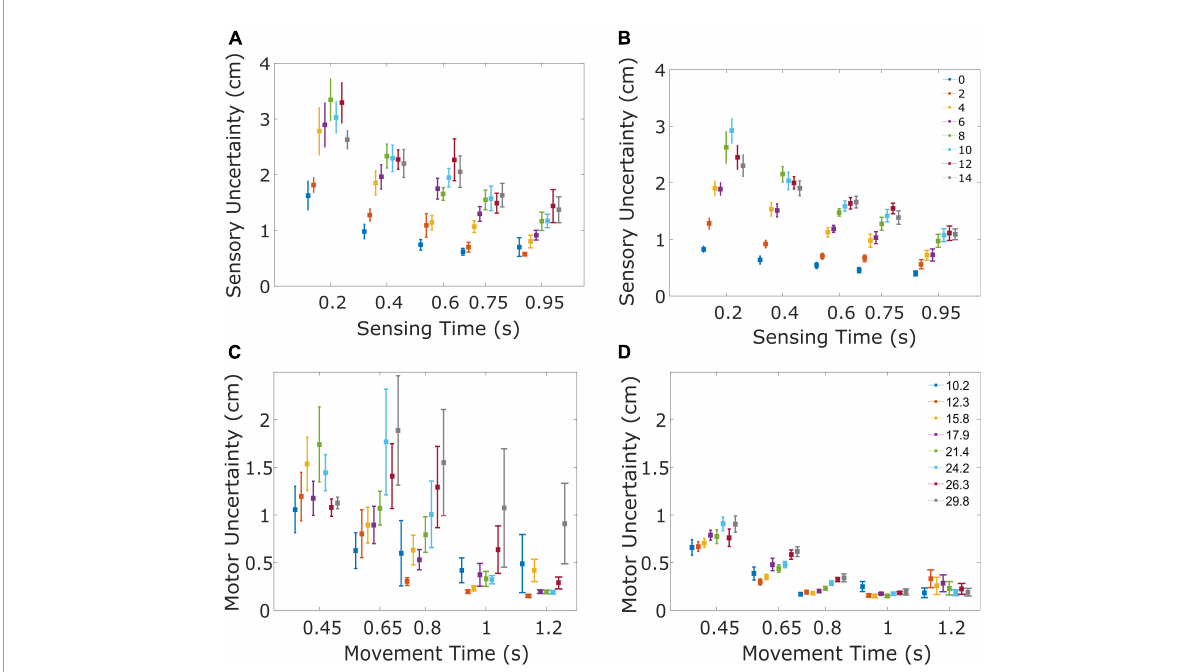
FIGURE3 Sensory and motor uncertainty. The four panels illustrate the sensory (A,B) and motor uncertainty (C,D) for patients (A,C) and controls (B,D) . (A) Sensory uncertainty for the PD patients decreases with sensing time and increases with the speed of the ball. Sensory uncertainty is shown for the five tested sensing times, separated for the eight horizontal velocities of the ball (color of the marker, ranging from 0 to 14 cm/s). Markers indicate the mean uncertainty across subjects, error bars indicate the standard error. To ensure each data point is clearly visible, a small displacement has been introduced on the time axis. (B) Same as (A) , now for the healthy control subjects. (C) Motor uncertainty for the PD patients decreases with movement time and increases with the speed of the ball/amplitude of the movement. Motor uncertainty is shown for the five tested movement times, separated for the eight movement amplitudes. Markers indicate the mean uncertainty across the subjects and the error bar indicates the standard error. (D) Same as (C) , now for the healthy control